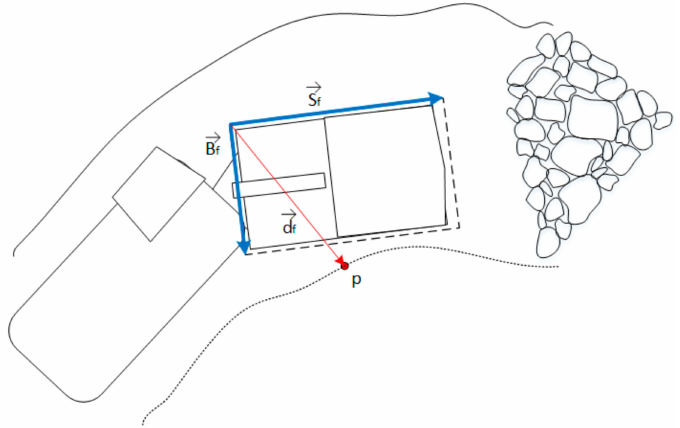
Figure 13. Simple collision check between the front body of the LHD and point P of the detected tunnel wall. Vectors Sf and Bf (in blue) of the collision bounding box are used alongside vector df (in red) to determine if point P is inside the bounding box.